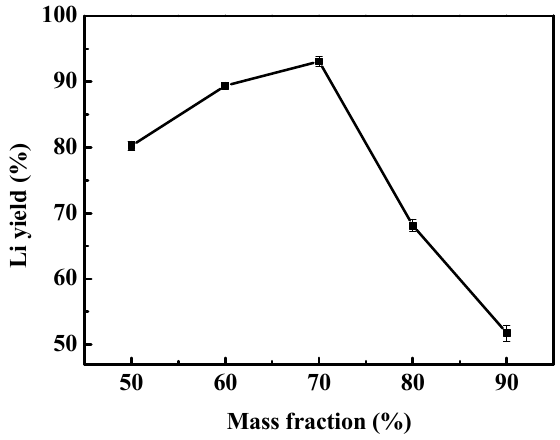
Figure 7. E ff ect of sulfuric acid mass fraction on the extraction of Figure 7. Effect of sulfuric acid mass fraction on the extraction of lithium. Figure 7. Effect of sulfuric acid mass fraction on the extraction of lithium.